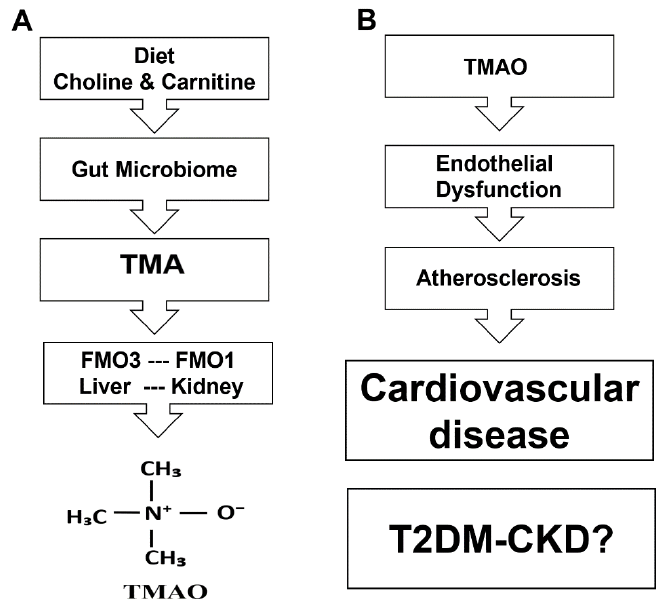
Figure 5. Speculation of metabolic pathway of TMAO ( A ), and the clinical impact of TMAO on development of cardiovascular disease ( B ).